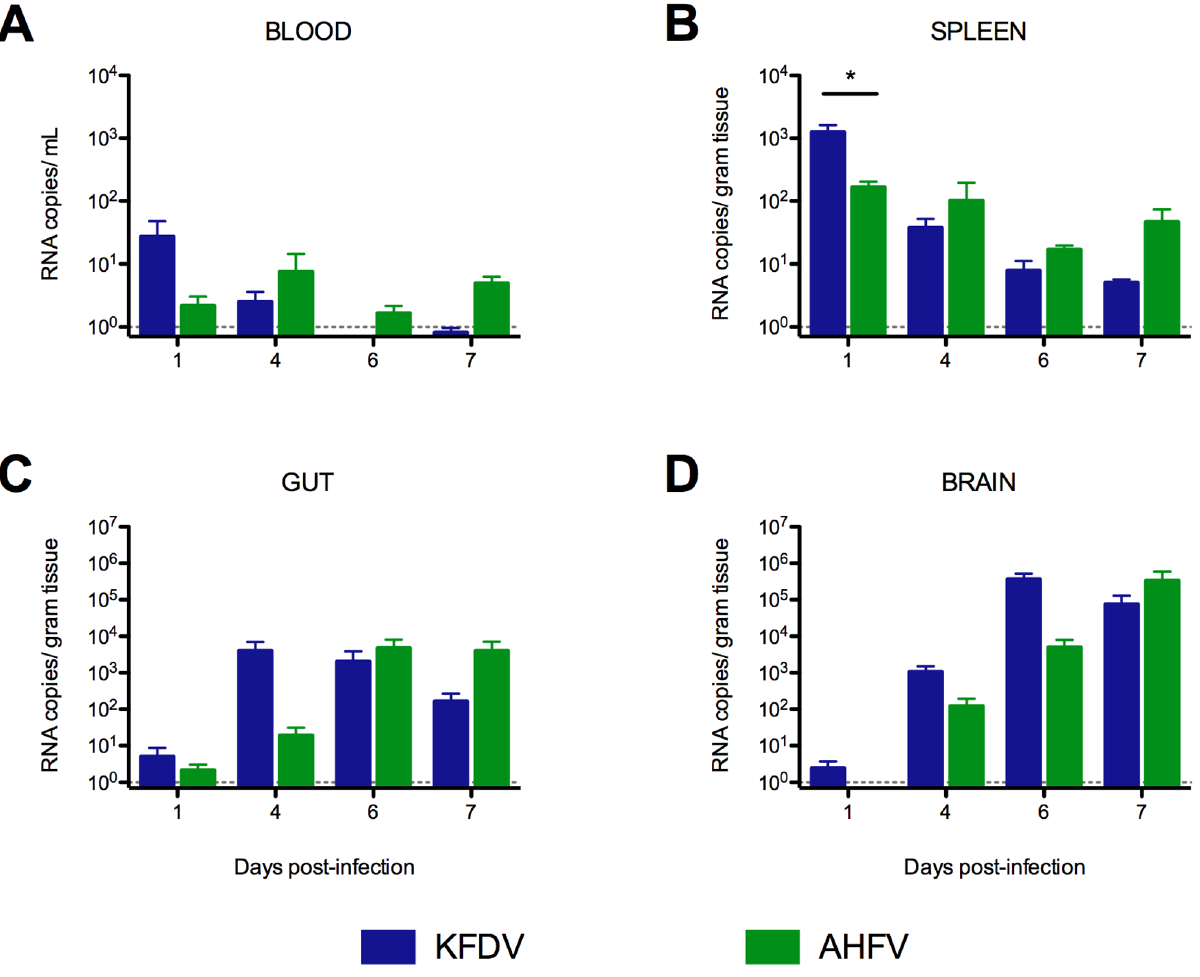
Figure 2. KFDV-infected mice have higher viral RNA loads than AHFV-infected mice early in infection. Viral RNA loads in the (A) blood, (B) spleen, (C) gastrointestinal tract and (D) brain were compared between KFDV- and AHFV-infected mice on 1, 4, 6 and 7 dpi. Asterisks indicate significant differences between KFDV- and AHFV-infected mice (n=5; p , 0.05). The gray dotted line denotes limit of detection of the assay.